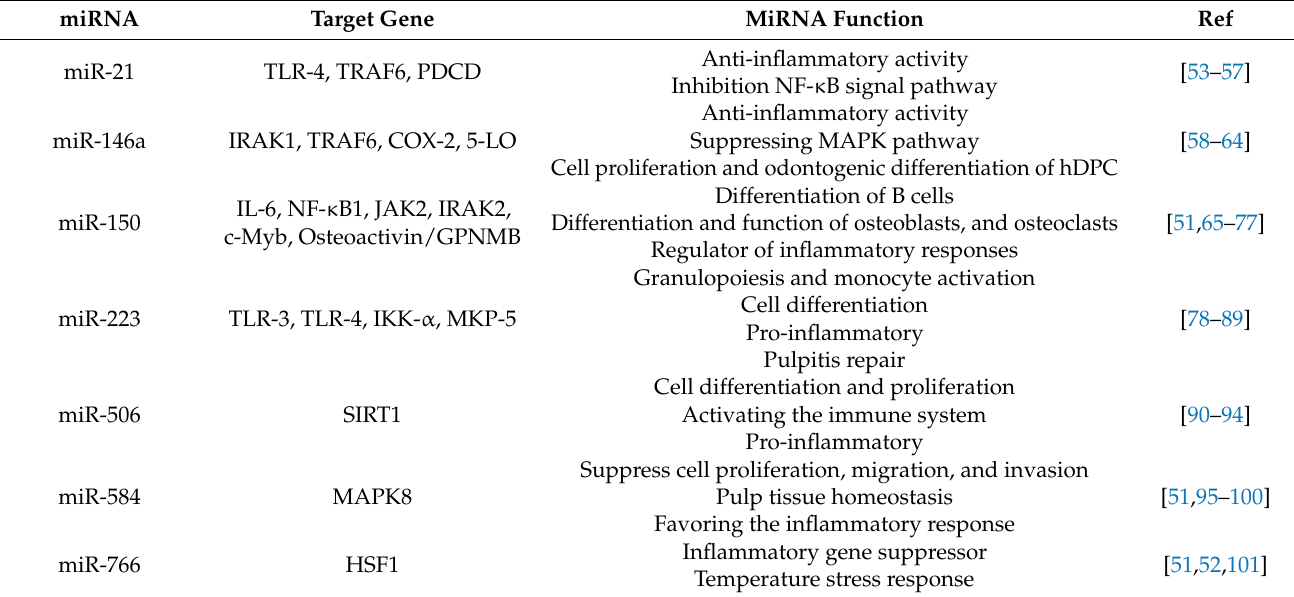
Table 1. Upregulated miRNAs in pulp